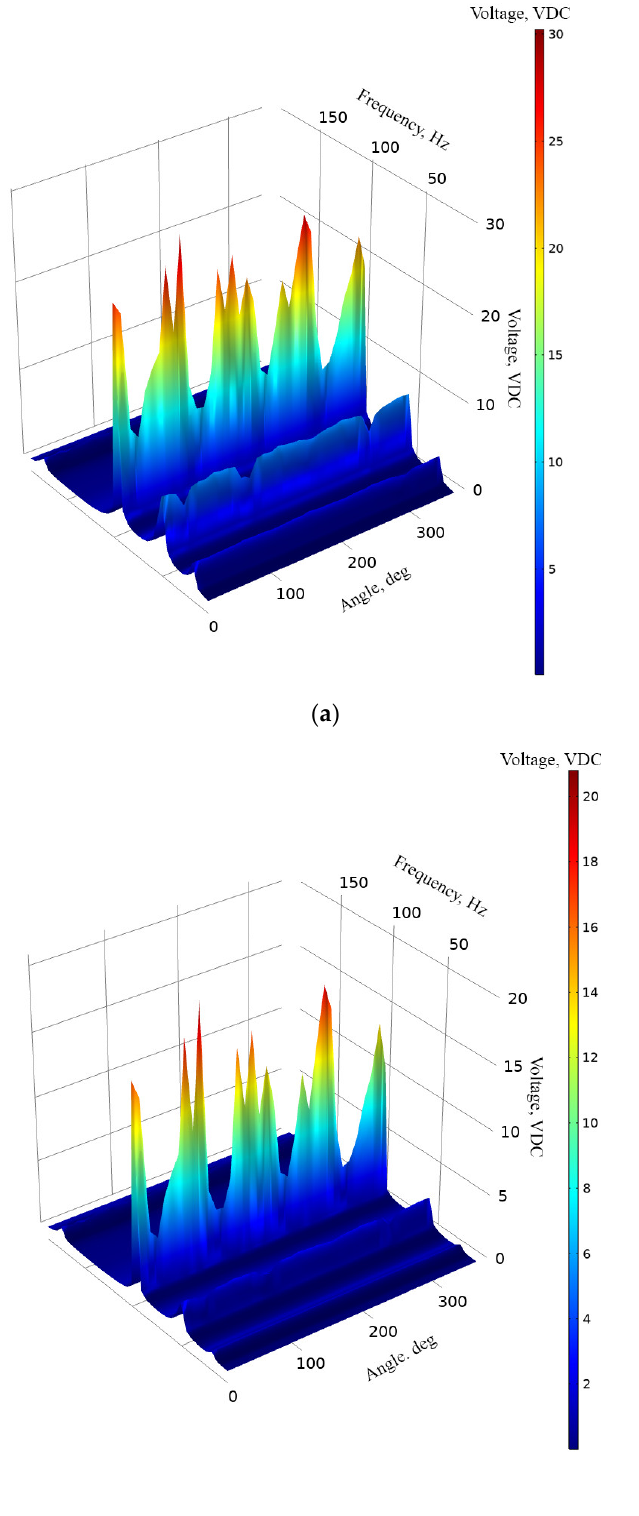
Figure 6. Frequency—voltage—angle of excitation characteristics of the energy harvester with different loads; ( a )—load equal to 1 MΩ; ( b )—load equal to 500 kΩ; ( c )—load equal to 250 kΩ.